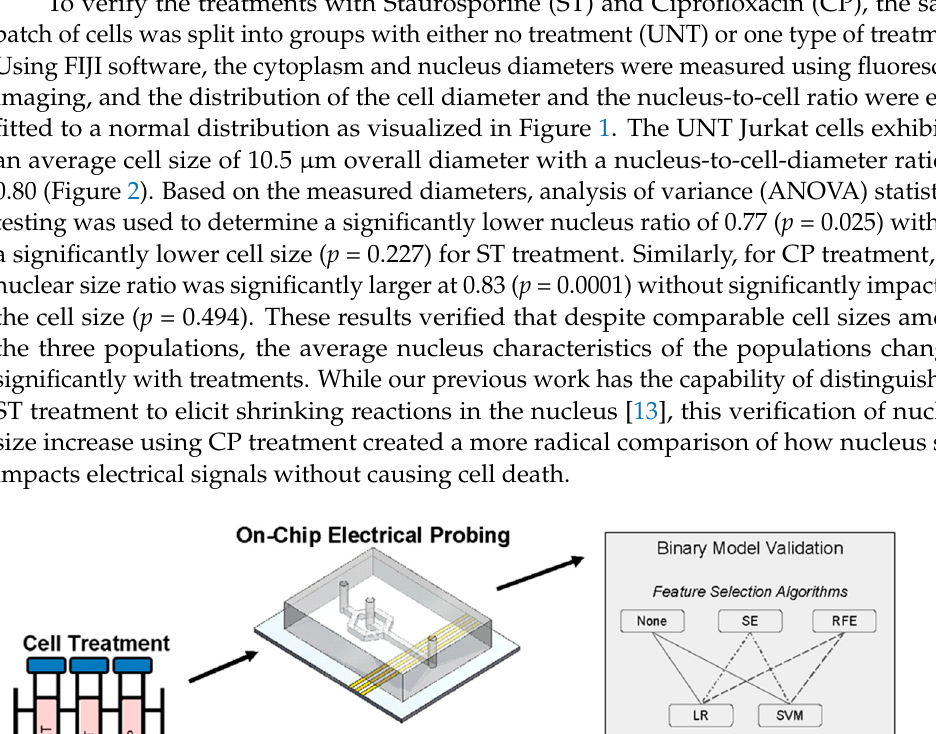
Figure 2. Cell and nucleus diameter measurements from fluorescence imaging. ( a ) Nucleus/cell diam- eter ratios among untreated, staurosporine (ST), and ciprofloxacin (CP) treated Jurkat cells. ( b ) Popu- lation cell diameter comparison among treatment types. (* p < 0.05, ** p < 0.01) Each box demonstrates the interquartile range (IQR) for the sample and the whiskers show the extension to 1.5 * IQR. 3.2. Visualization of Electrical Spectra Upon collection of S-parameter spectra from UNT (n = 53), ST (n = 43), and CP-treated cells (n = 39) using the microfluidic flow device outlined in our earlier work [15–17], the spectra were compared among the two treatment conditions and the untreated cells. Fig- ure 3 shows the overlap in the mean spectra (lines) and differences in standard deviation (shadows) at each frequency between the treated and untreated groups. While there is a clear population overlap between UNT, ST, and CP-treated cells, there are still certain characteristics that can be visually identified in the spectra that are specific to treatment. For example, in ST-treated cells, there is a shift of the peak to a higher frequency around 9 GHz of Δ S11 along with a decreased slope in the 10-MHz range of Δ S21, shown in red in Figure 3a,b, respectively. Alternatively, CP-treated cells show a deeper dip at 1 GHz of Δ S11 and an increased slope in the 10-MHz range of Δ S21 appearing blue in Figure 3. Based on previous circuit modeling focusing on how double-shell model compartment properties can impact different portions of spectra, these changes are consistent with in- creased resistance in the ST-treated cells and decreased resistance in CP-treated cells for both the nucleoplasm and cytoplasm [18]. For ST-treated cells, the changes are also con- sistent with the spectra changes seen in the previous work, and the current work measur- ing a much larger number of cells to allow ML-based classification.